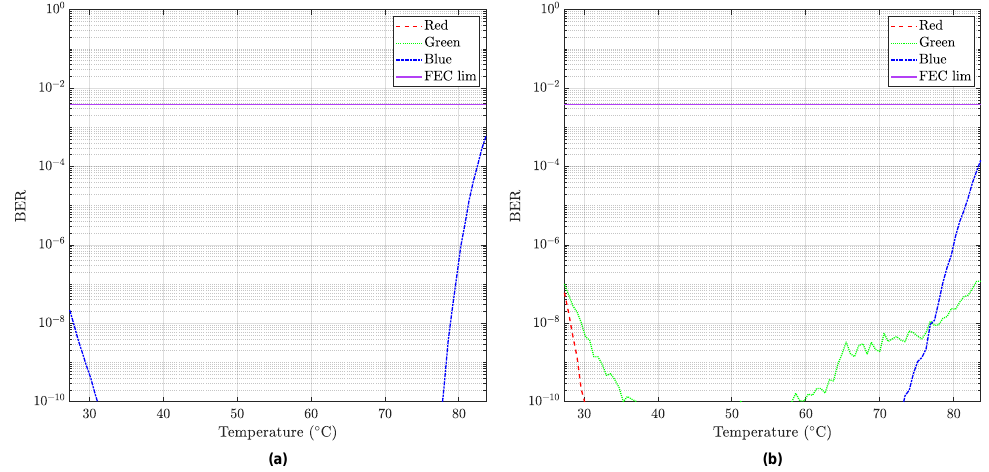
Figure 10. BER at different temperatures, compensating the channel using the CSI corresponding to 60°C and with a high SNR value (30 dB). ( a ) Sony IMX249 and ( b ) Foveon X3. Dashed line, dotted line, and dash-dot line correspond to red, green, and blue,